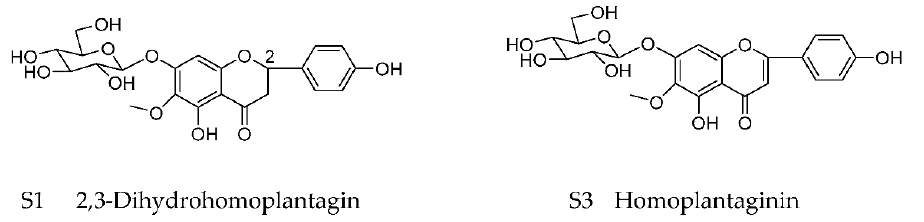
Figure 1. Chemical structures of dihydrohomoplantagin and homoplantaginin (named compound S1 and compound S3, respectively).